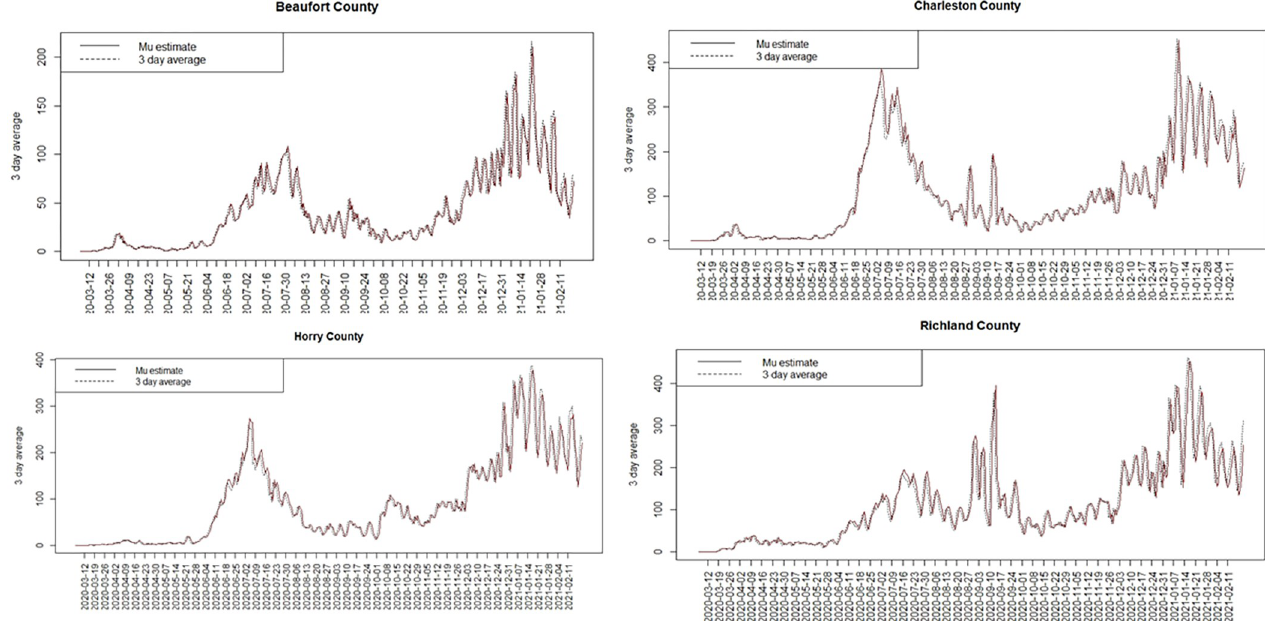
Fig 5. Comparison of four SC counites with fitted model 4.